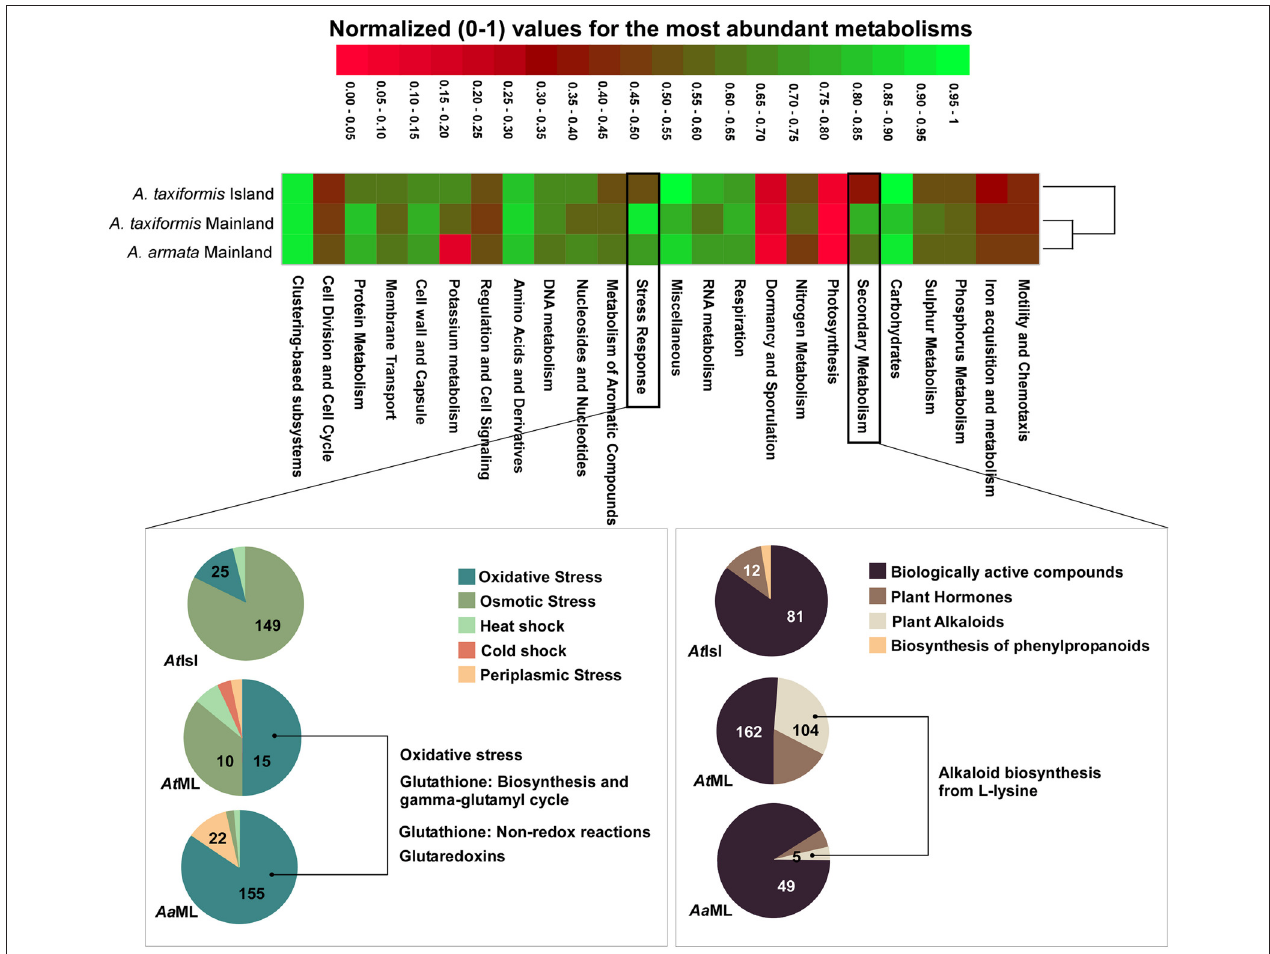
FIGURE 4 | Differential clustering of the most abundant metabolisms of A. armata (mainland) and A. taxiformis (mainland and island). Normalized (following MG-RAST normalization procedure) values were used to draw the heatmap. The hierarchical dendrogram was clustered using Ward’s minimum variance method with Bray-Curtis distance metric. Level 2 metabolisms of the most abundant level 1 metabolic assignments for Mainland samples (compared to island samples) were represented in pie charts and level 3, of the most relevant metabolism from level 2, was described. Absolute numbers of hits for the most representative functions are represented in the corresponding slice. Aa ML- A. armata mainland, At ML- A. taxiformis mainland, At Isl- A. taxiformis Cape Verde. Graphics were manipulated to fit in the same figure (heatmap + pie charts) and pie charts colors were changed so the same feature color would match for all the samples (Raw data in Table